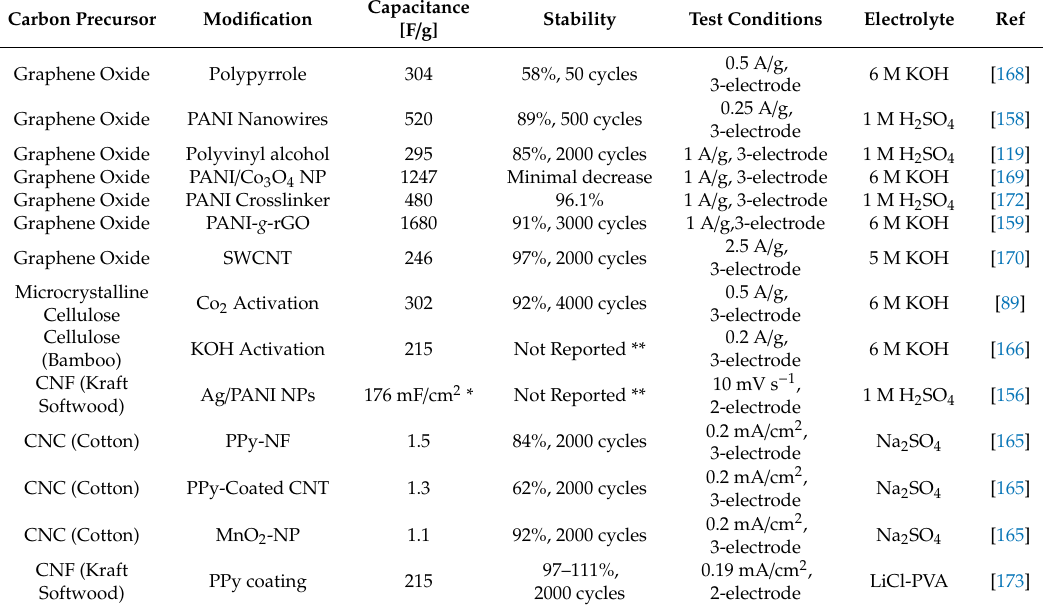
Table 2. Comparison of the capacitance and stability of select graphene, carbon nanotube, and cellulose aerogel composites for supercapacitor electrodes. * Areal capacitances reported only. ** Values not reported for this